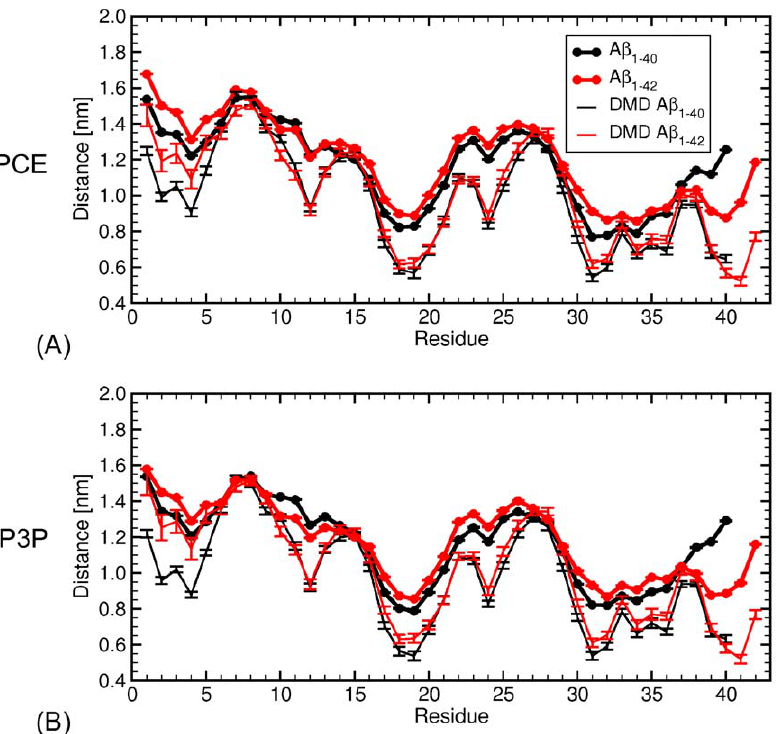
Figure 5. The average distance from the CM of each amino acid residue in A b dimers. The thick black and red curves correspond to the average distances from the CM of amino acids within A b 1 { 40 and A b 1 { 42 dimers, respectively, acquired by MD using (A) SPCE and (B) TIP3P water model. The thin black and red curves correspond to the average distances from the CM of amino acids within the corresponding DMD-derived A b 1 { 40 and A b 1 { 42 dimers, respectively. The error bars are SEM values.